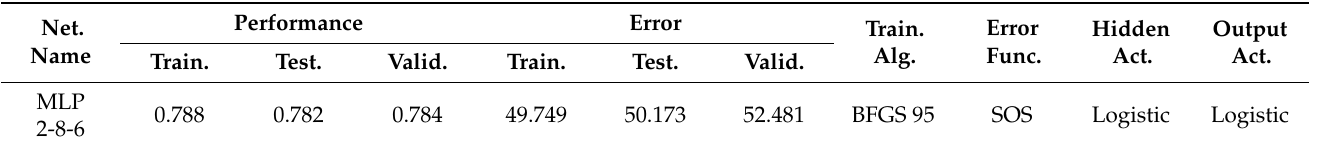
Table 3. Artificial neural network model summary (performance and errors), for training, testing, and validation cycles.